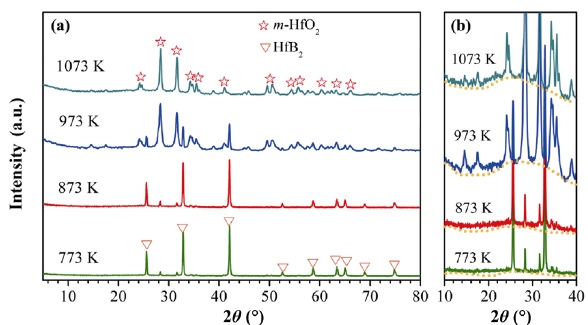
Fig. 6 XRD analysis of the as-synthesized HfB 2 powders after oxidation tests: (a) XRD patterns of the as-synthesized HfB 2 powders after oxidation tests at various temperatures; (b) high magnification of XRD patterns with 2 θ from 10° to 40°.